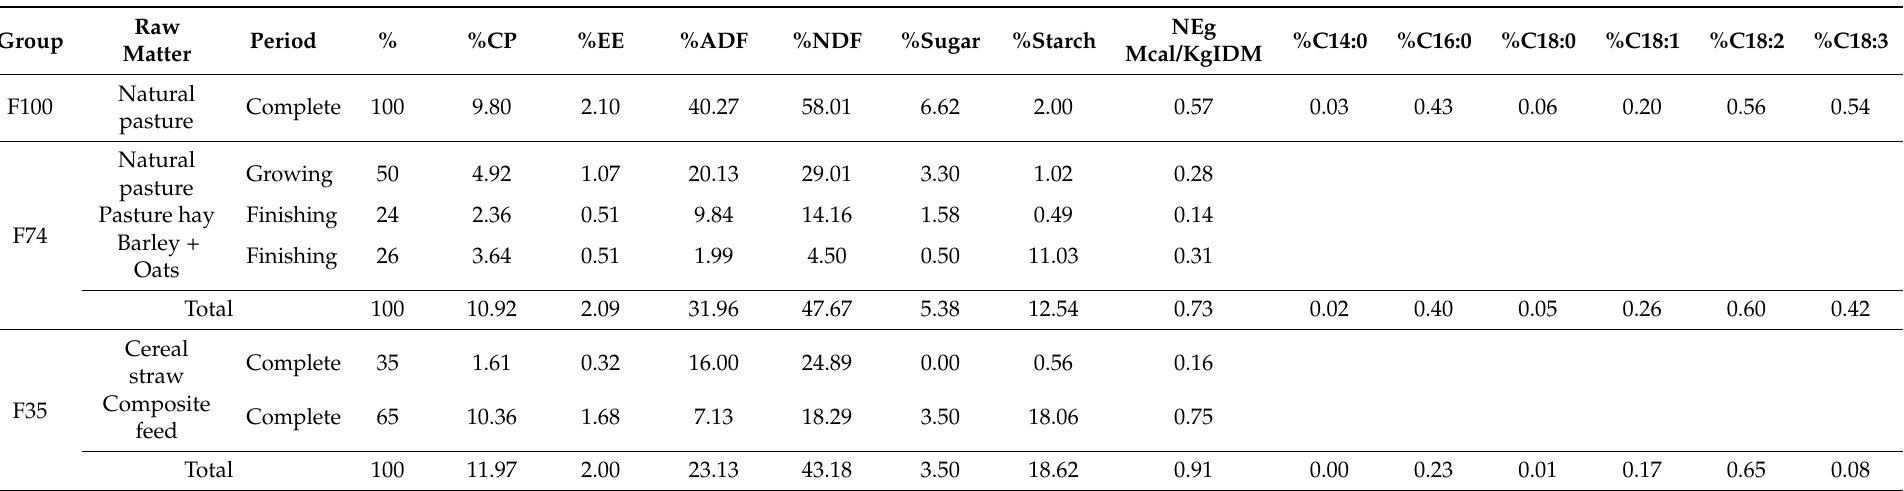
Table 1. Nutritional composition of the intakes of the different rearing systems (%Dry